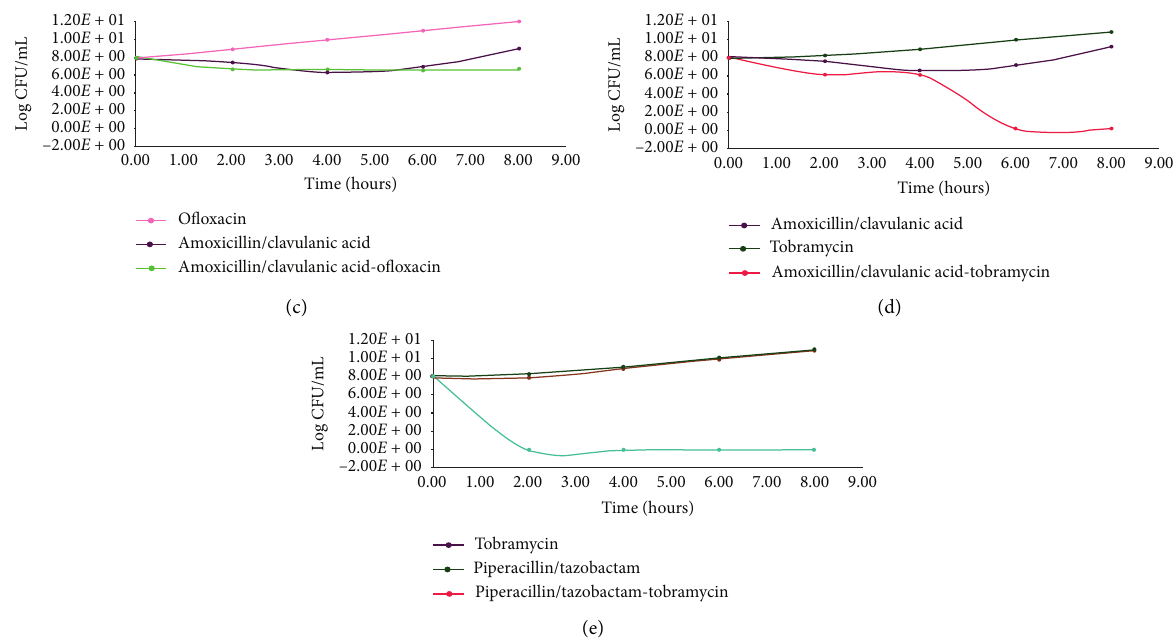
Figure 4: Collateral relationship network of antibiotic combinations from diverse subclasses on MRSA